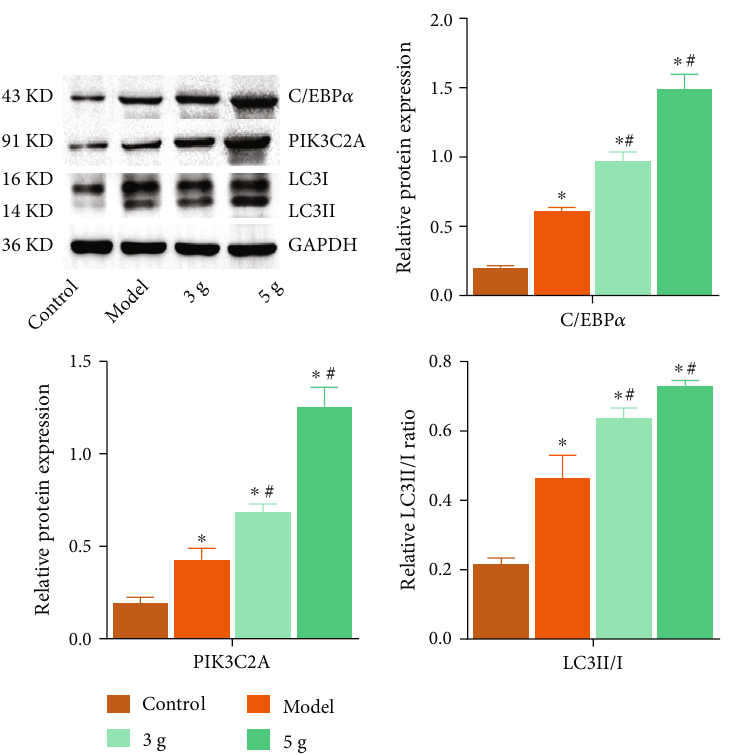
Figure 9: The impact of C/EBP α , PIK3C2A, and LC3 by stretch stress in aortic rings of AD rat. Representative Western blot analysis and mean fold change of C/EBP α , PIK3C2A, and LC3 expression in aortic dissection rings of AD rat after being stretched by 0 g (model), 3g (3 g), and 5g (5 g) for 30 minutes. Aortic rings of normal rat were used as control. ∗ P < 0 : 05 vs. control, # P < 0 : 05 vs.